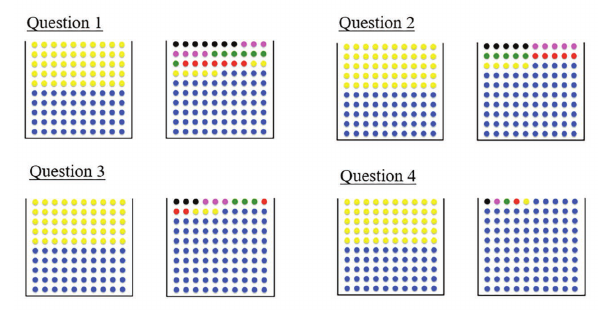
FIGURE 2 | Example pre‐ and post-test questions testing entropy intuitions. Students are asked for each pair of code jars which of the two would be harder/easier to play with or whether the two urns are equally hard. Answers to these questions quantify entropy intuitions (Crupi et al.,